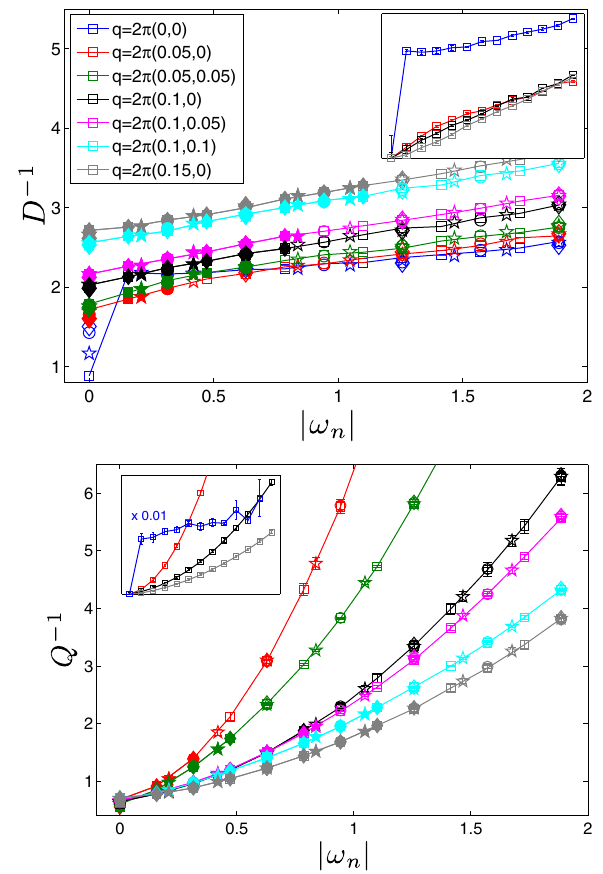
FIG. 22. Inverse nematic and quadrupolar correlators versus j q j FIG. 23. Frequency dependence of the inverse nematic corre- for all orientations of q at h ¼ h and temperatures T ¼ 0 . 1 , 0.05, lator D − 1 (top) and inverse quadrupolar correlator Q − a (bottom) c 0.025 (curves are offset for clarity). Momenta from multiple at h ¼ 4 . 5 ≈ 1 . 3 h for a variety of small momenta q in an L ¼ 20 c system sizes (represented by squares for L ¼ 16 , circles for system at temperatures T ¼ 0 . 025 , 0.033, 0.05, 0.1 (shown as L ¼ 20 , and diamonds for L ¼ 24 ) fall on the same curve, squares, stars, circles, and diamonds, respectively). Here, there is indicating that the properties shown are in the thermodynamic a nonvanishing energy scale associated with nematic fluctuations limit. On the plot of D − 1 at the left, the dotted lines are the since we are deep in the disordered phase, but the frequency functional approximant, Eq. (6). On the plot of Q − 1 at the right, dependence is similar to that at h ¼ h (see Fig. 12). Different c the dotted lines are a linear fit to the data at nonzero momentum, colors represent different values of q , and filled symbols mark q j . The insets show the subset of the data with a temperature-independent slope. The apparent linear < v frequencies j ω n j F j momentum dependence of Q − 1 suggests a critical power law, with T ¼ 0 . 025 and momenta along the (10) direction shifted by though with an apparently different exponent than the one found their zero-frequency values. For the inset of the bottom panel, the data at q ¼ 0 are scaled down by a factor of in D − 1 .